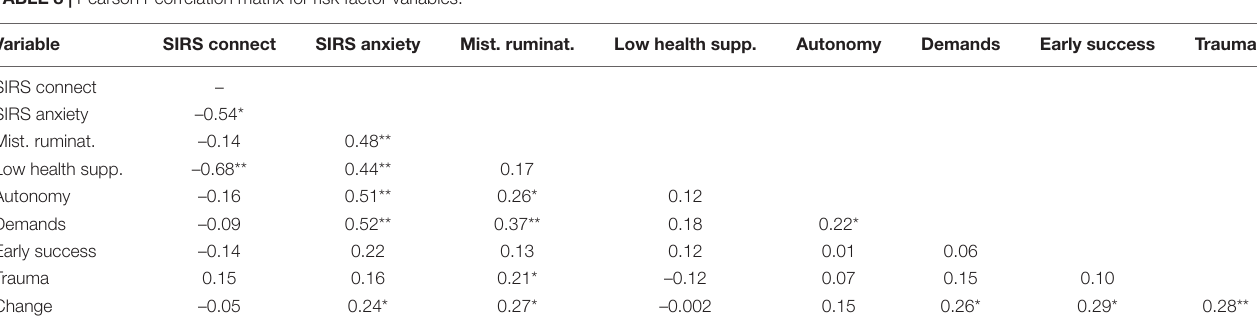
TABLE 8 | Pearson r correlation matrix for risk factor variables.